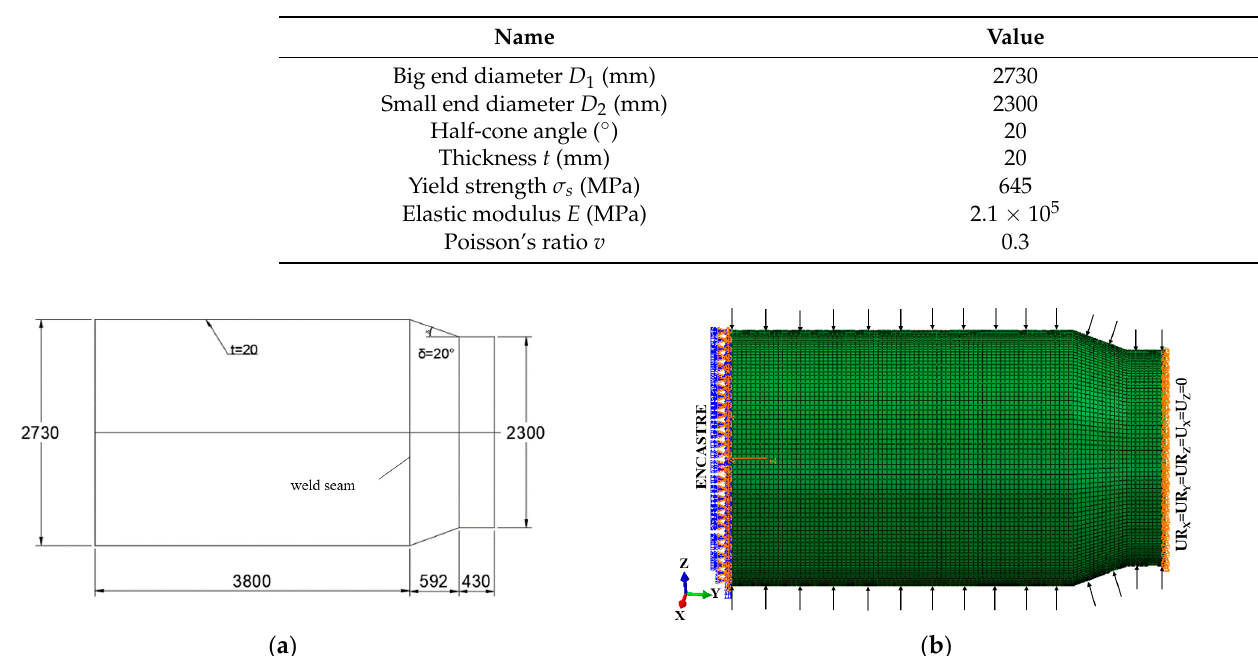
Figure 2. Conical-cylindrical shell model. ( a ) Geometric model ( b ) Numerical model. Table 1. Geometric and physical parameters of the model.